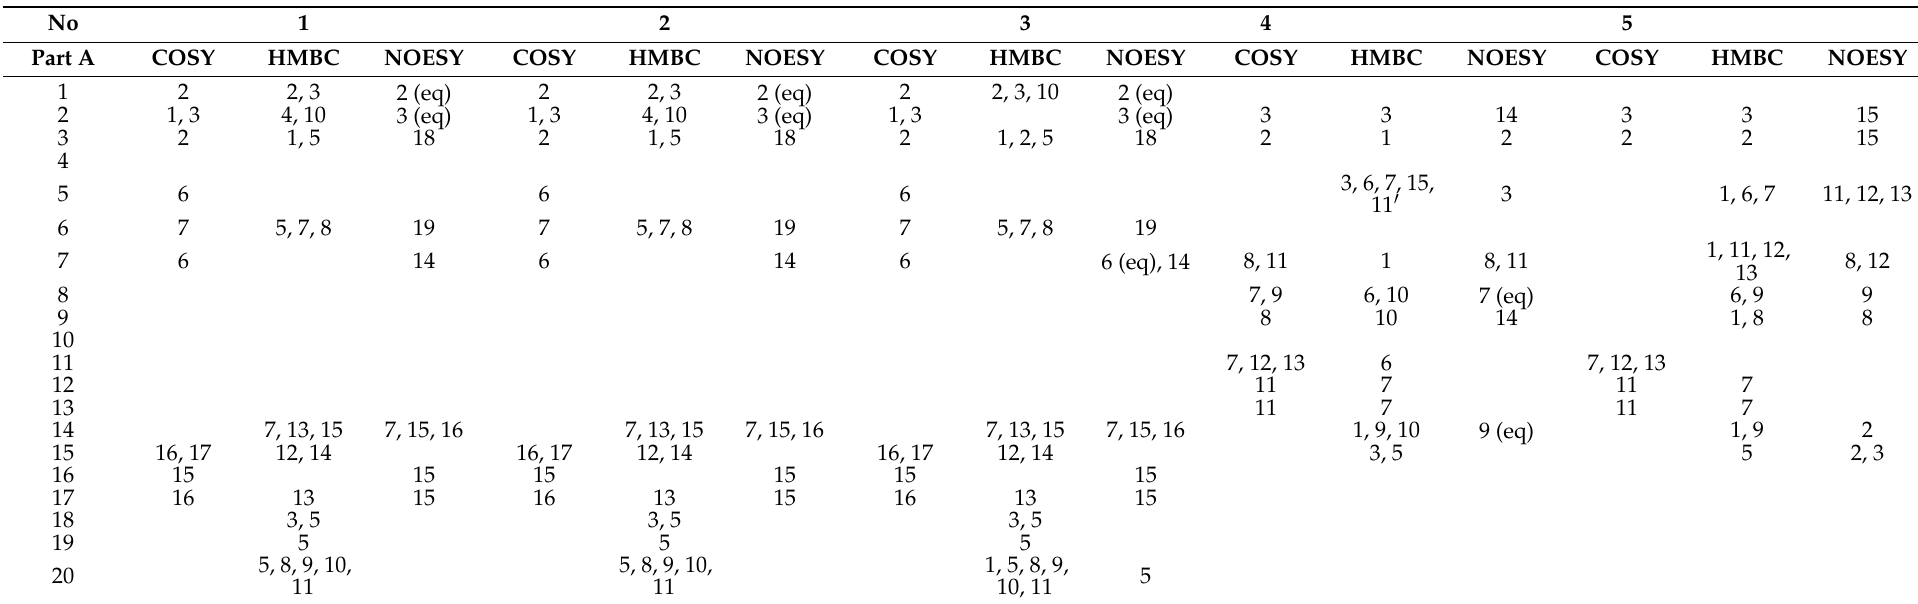
Table 3. 2D-NMR data for compounds 1 – 5 in CDCl 3 ( δ in ppm, J in Hz, 500 MHz in CDCl 3